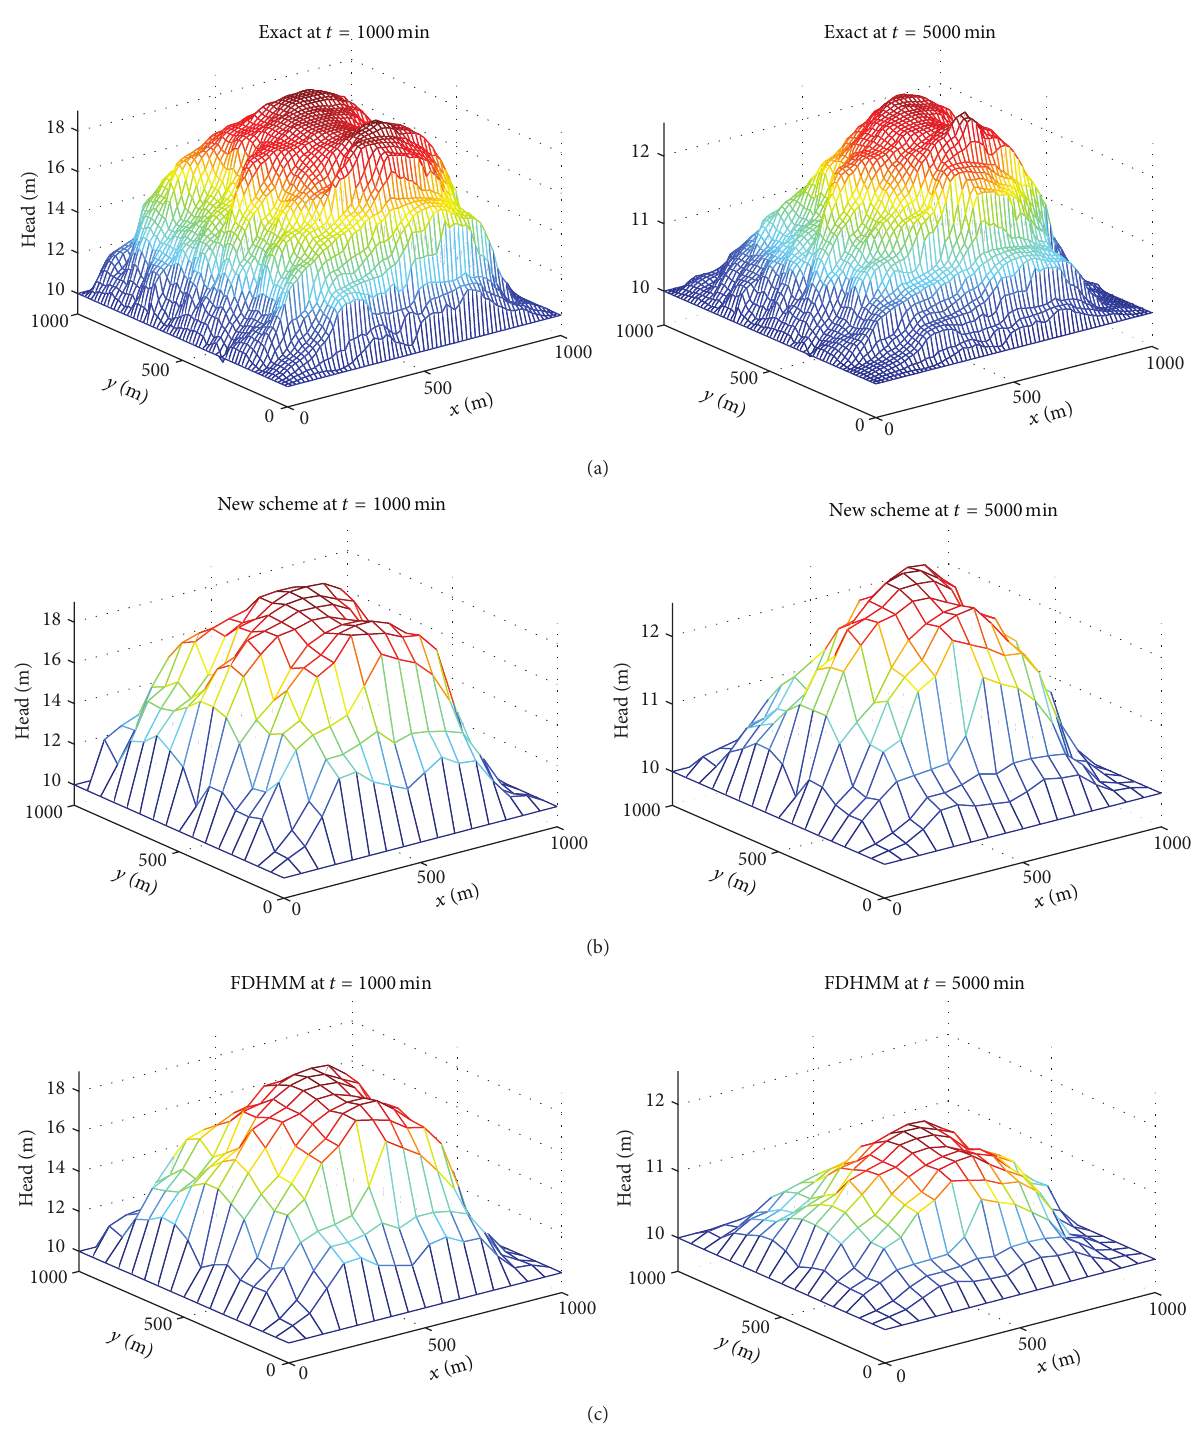
Figure 10: Exact solution (top), the coarse solutions of the new scheme (middle), and FDHMM (bottom) at times 𝑡 = 1000 min (left) and 5000 min (right) for aquifer response to sudden change in reservoir